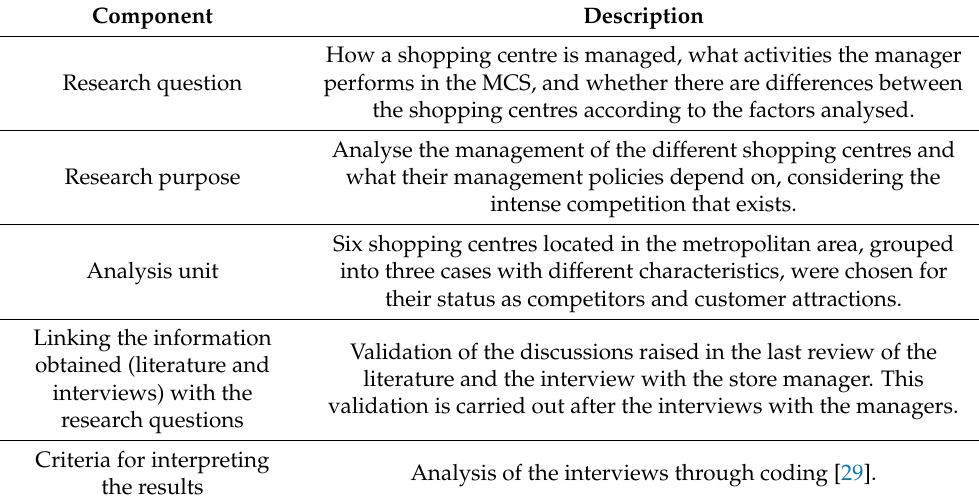
Table 2. Case study design phase 1